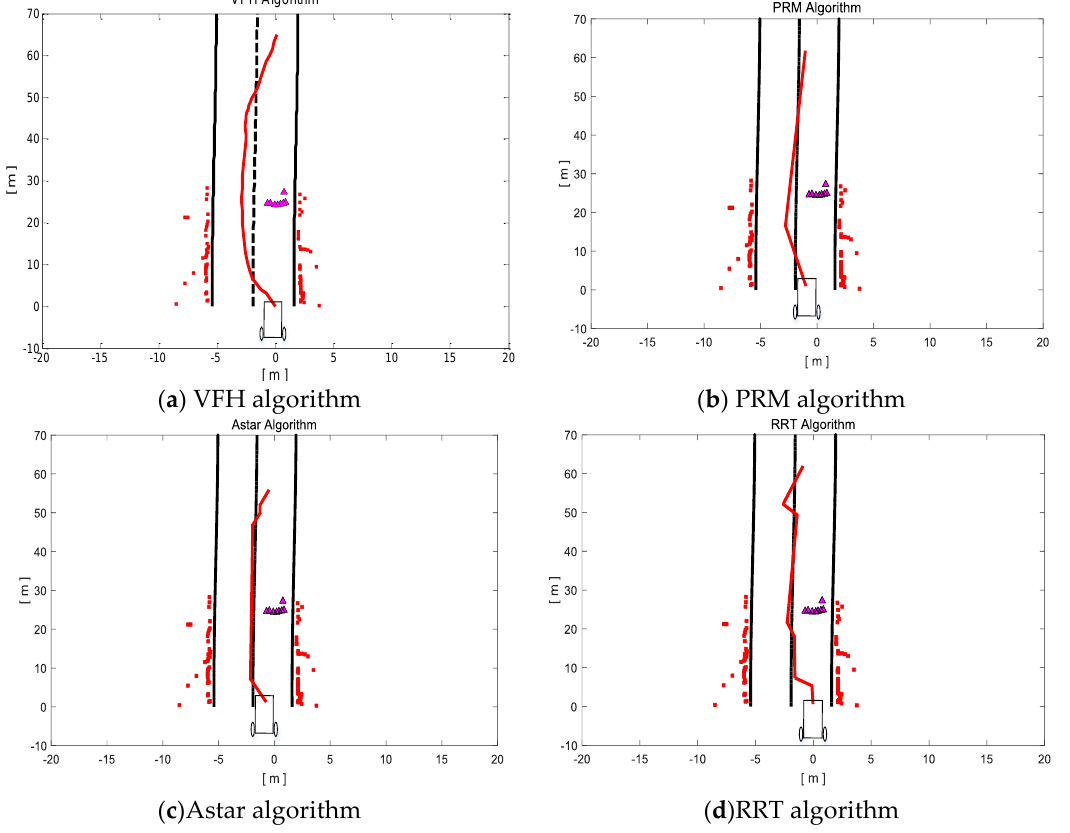
Figure 16. Four algorithms simulation experiment results. Table 2. The time complexity evaluation comparison (secs) of different algorithms.